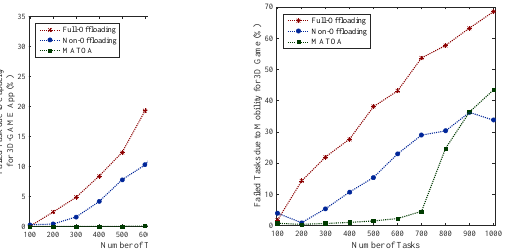
HEFT MHEFT MinMax FCFS Offloading Tasks Without Fault Figure 12. Task Scheduling Heuristics Performance